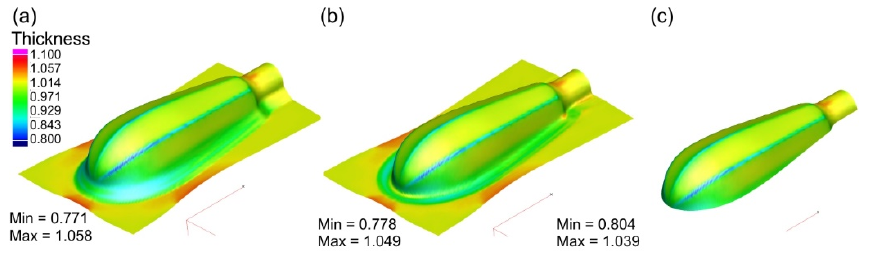
Figure 9. Thickness distribution in drawn part wall after: ( a ) initial forming; ( b ) supplementary Figure 8. Strain distribution (zones by quality) in comparison with forming limit diagram. forming; ( c ) final forming in dry conditions.